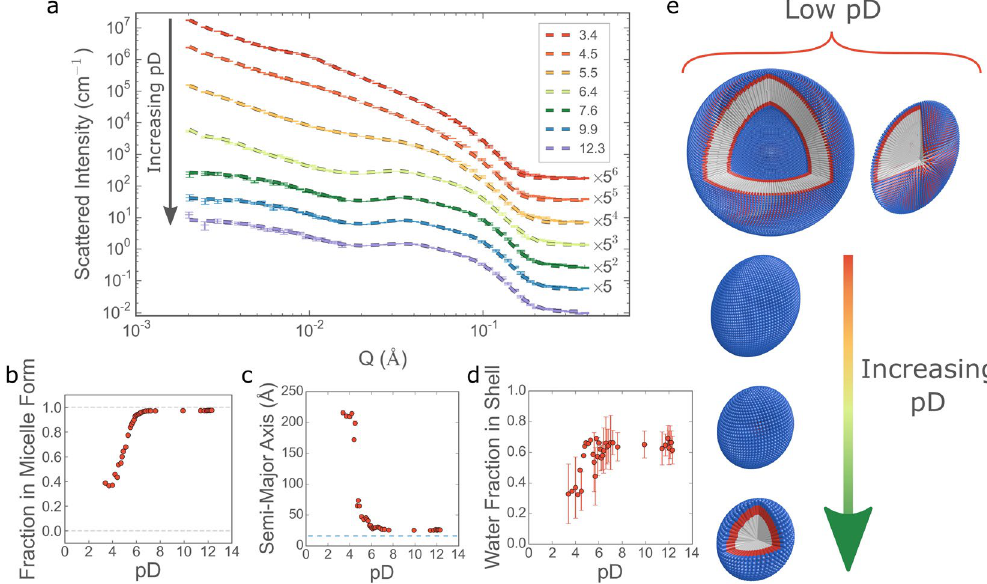
Figure 5. ( a ) Representative azimuthally-averaged intensity profiles vs Q from the single NaOD titration. Data are represented by thin horizontal lines with error bars and fits to the model described in the text are shown as thick dashed lines. pD values for each dataset are given in the legend and all profiles with an adjacent number have been shifted in intensity for clarity. Plots ( b – d ) show the evolution of the fitted parameters with pD: ( b ) fraction of surfactant in micellar form, ( c ) semi-major axis of the ellipsoidal micelles (the maximum semi- minor axis is displayed as a dashed line for reference) and ( d ) volume fraction of D 2 O in the micelle shell. A cartoon of the corresponding structures, as they are interpreted in this work, is shown in ( e ) (not to